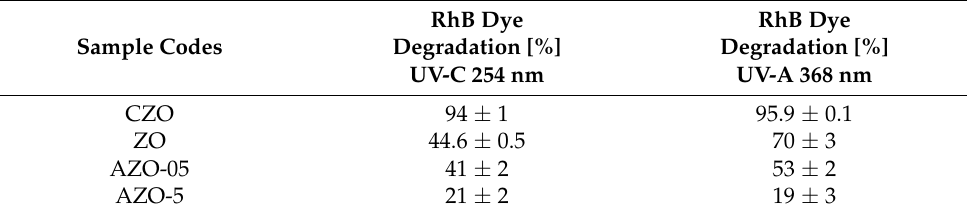
Table 2. Degradation of RhB after 20 min of UV-C and UV-A light irradiation in the presence of commercial ZnO, undoped ZnO, 0.5 and 5 at% Al-doped ZnO nanopowders.